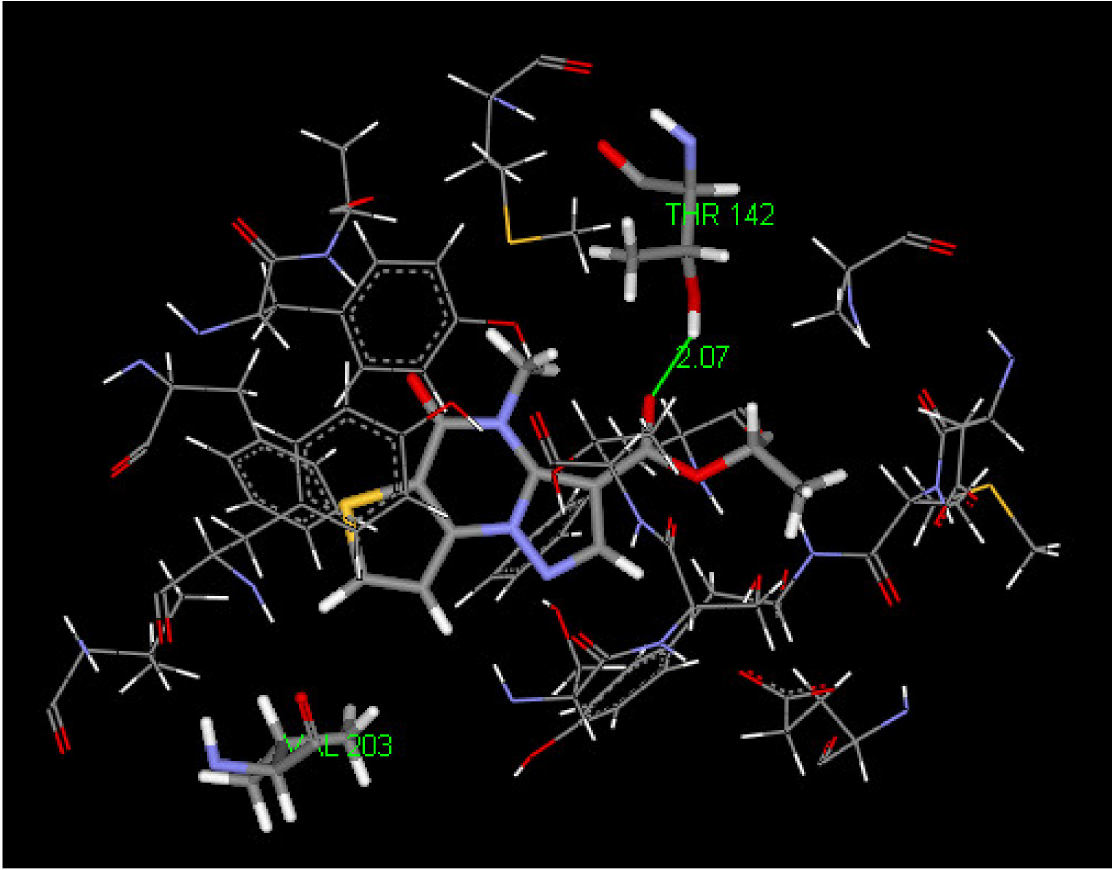
Figure 6. Hydrogen bond interaction of compound 12c in the last frame of dynamic